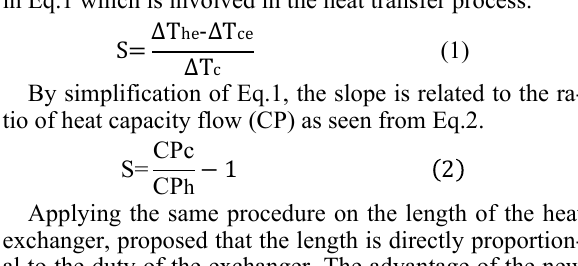
Figure 2. New graphical representation